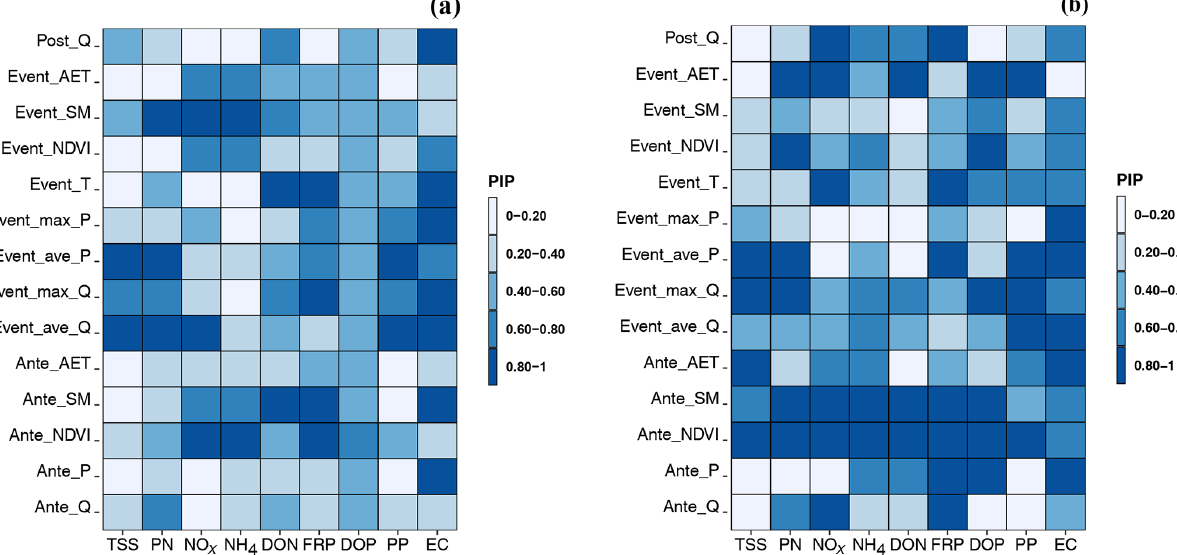
Figure 4. Posterior inclusion probability (PIP) of each candidate predictor for (a) cluster 1 (wet) catchments and (b) cluster 2 (dry) catch- ments. Dark blue refers to high PIP, and light blue refers to low PIP. The definitions of the abbreviations of each predictor on the y axes are given in Table